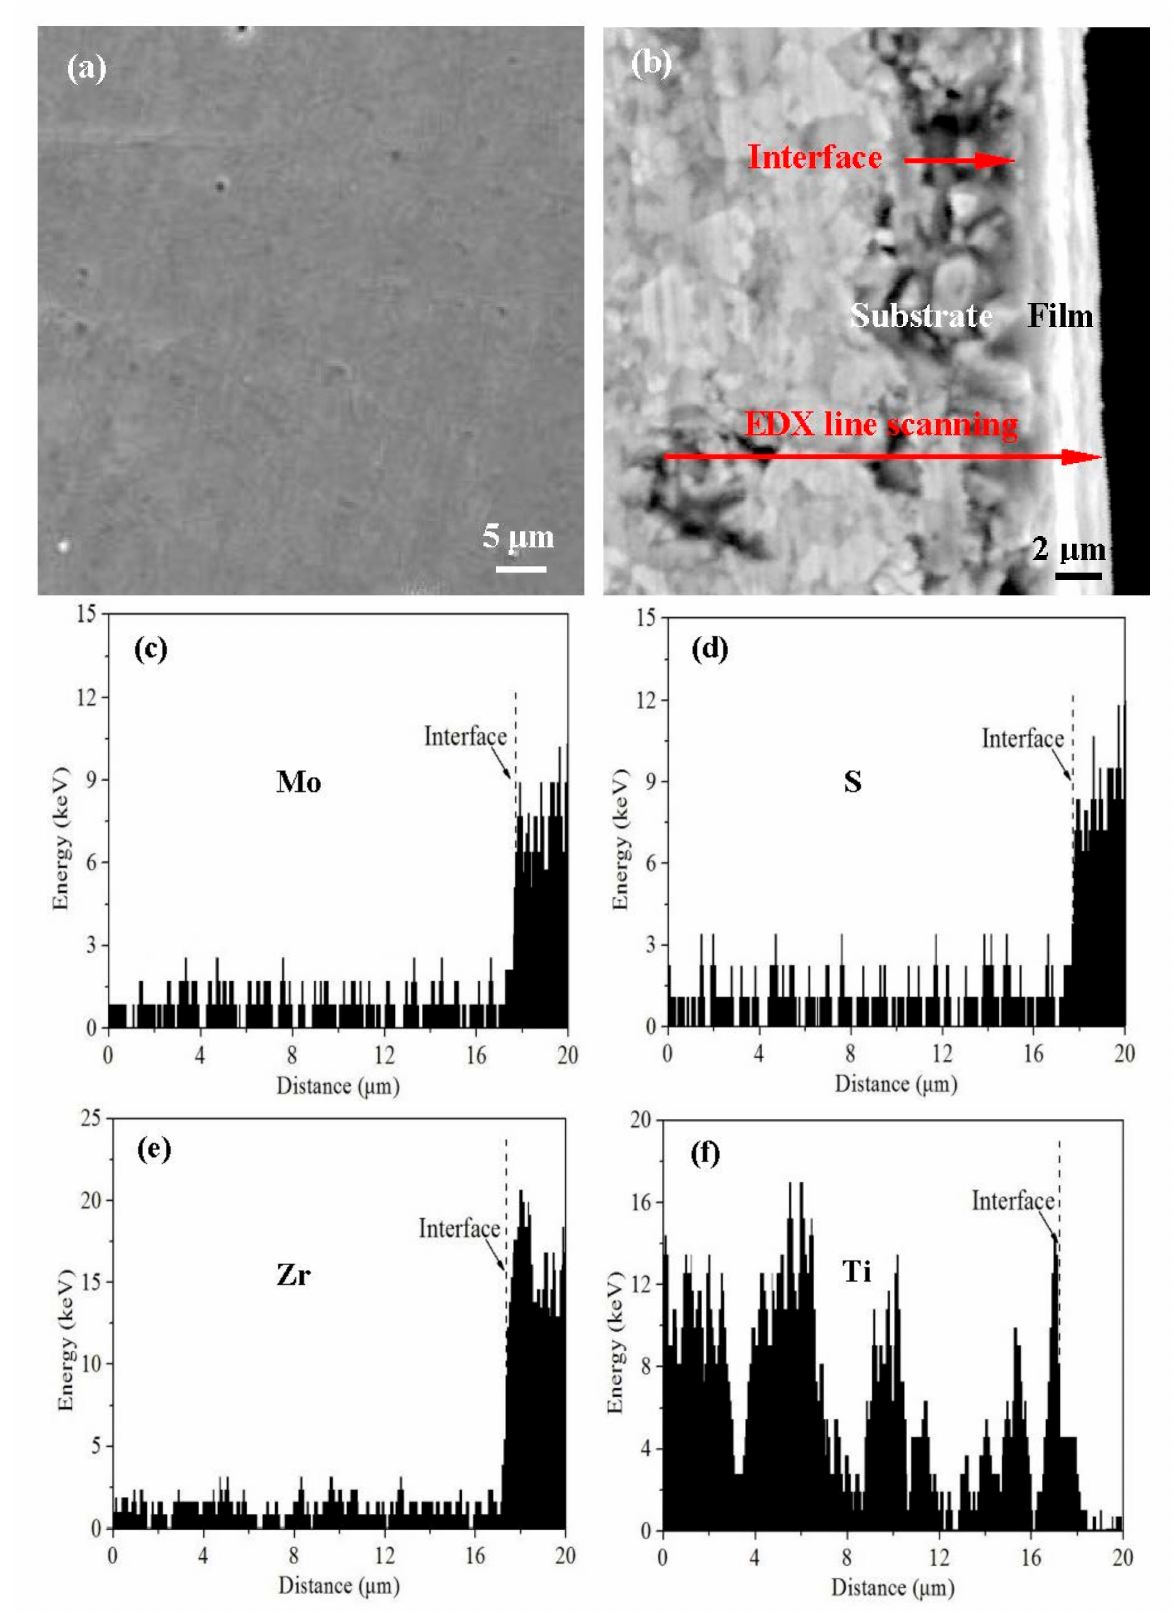
Figure 2. Surface ( a ), cross-section ( b ) morphologies for the T180 sample and the EDX line scanning of Mo ( c ), S ( d ), Zr ( e ) and Ti ( f ) elements in Figure